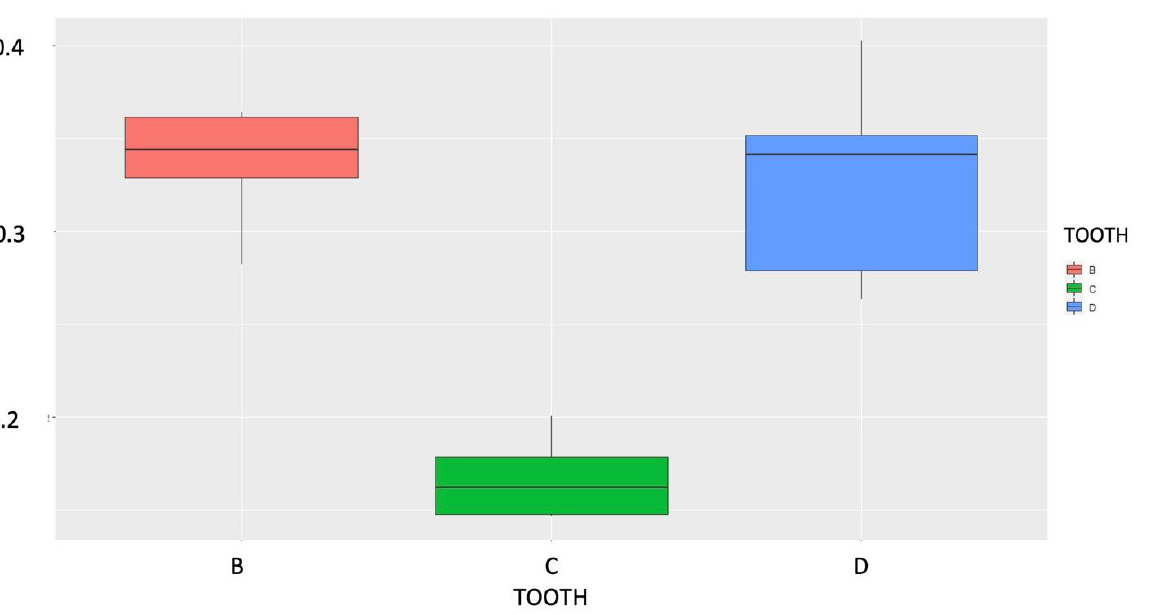
Figure 2. Box-plot regarding ‘Toothpaste A’; Tooth B, C and D represents tooth condition as in Table